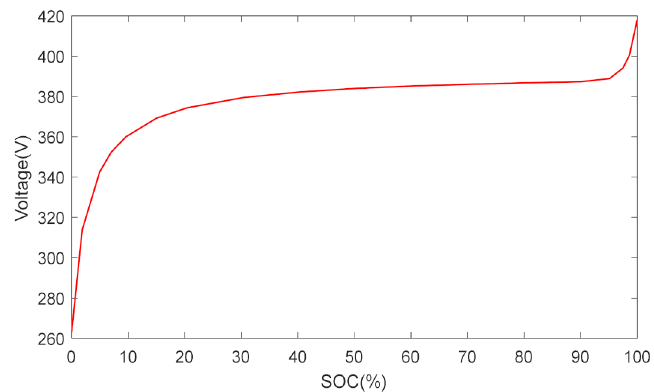
Figure 6. Open circuit voltage of the